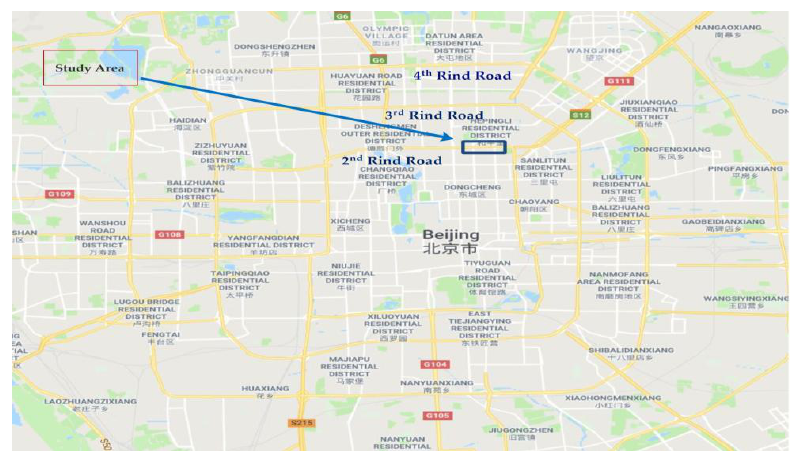
Figure 4. Second ring road (from Google Maps). Note: The Chinese words on map indicate names of surrounding infrastructure.